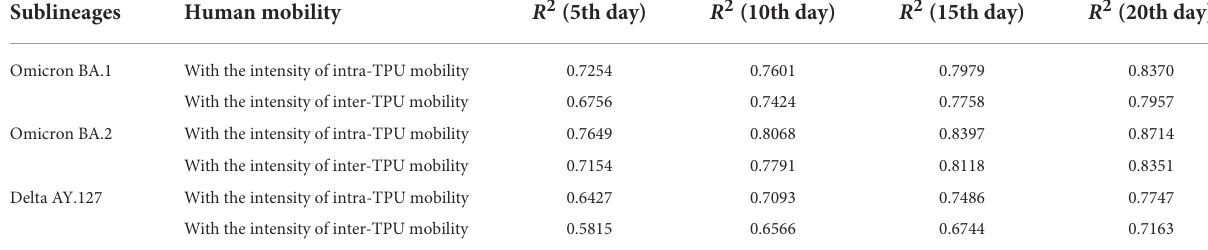
TABLE 2 The correlation between the symptom onset risk and the intensity of intra-TPU and inter-TPU mobility during the spread of Omicron BA.1, BA.2 and Delta AY.127 in Hong Kong. Sublineages Omicron BA.1